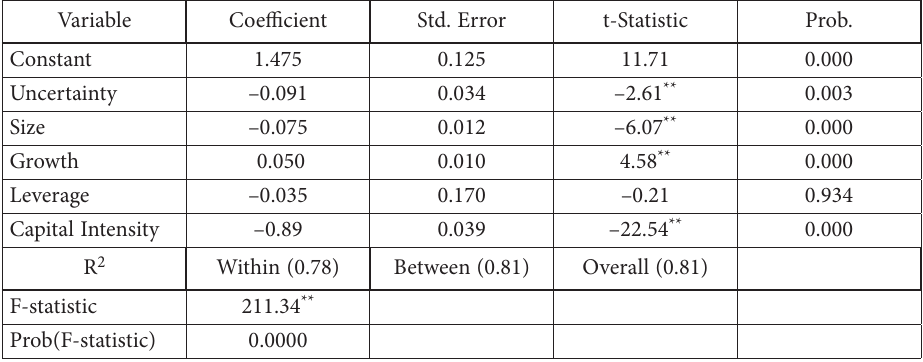
Table 5. Panel Regression Analysis by using Fixed effect